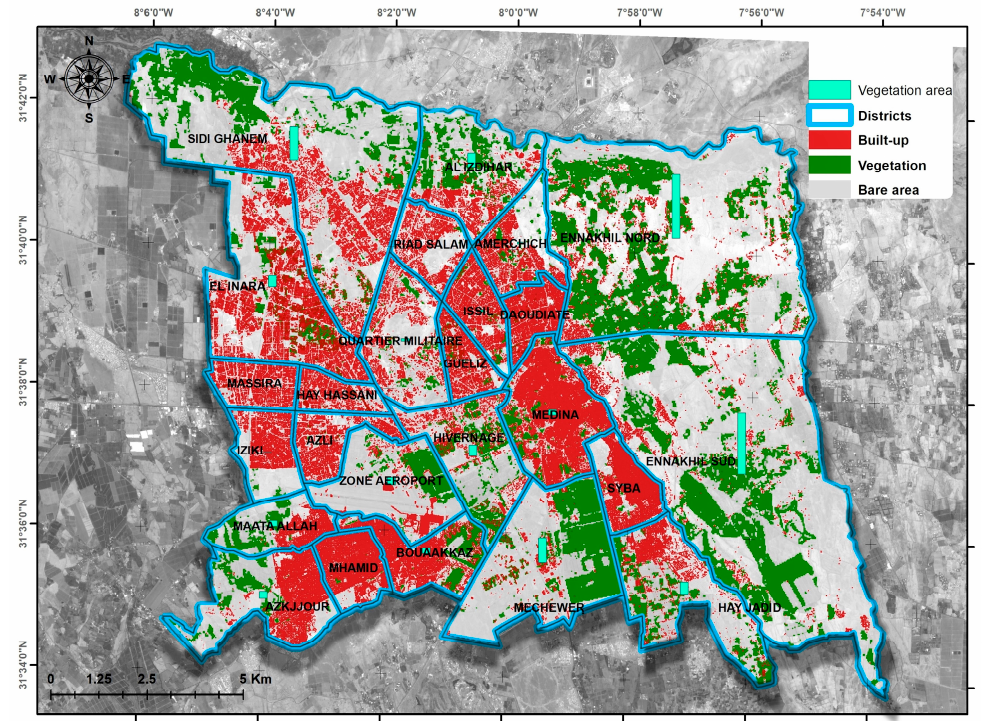
Figure 3. Variation in vegetation in relation to built-up and bare surfaces.